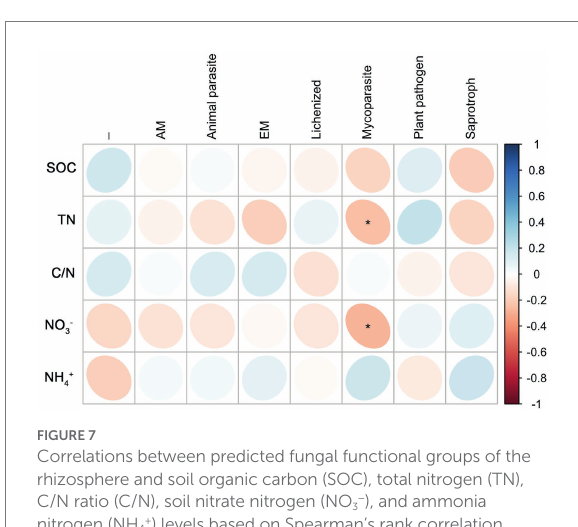
FIGURE 7 Correlations between predicted fungal functional groups of the rhizosphere and soil organic carbon (SOC), total nitrogen (TN), C/N ratio (C/N), soil nitrate nitrogen (NO 3 − ), and ammonia nitrogen (NH 4+ ) levels based on Spearman’s rank correlation. Significant difference was indicated as follow: * p <